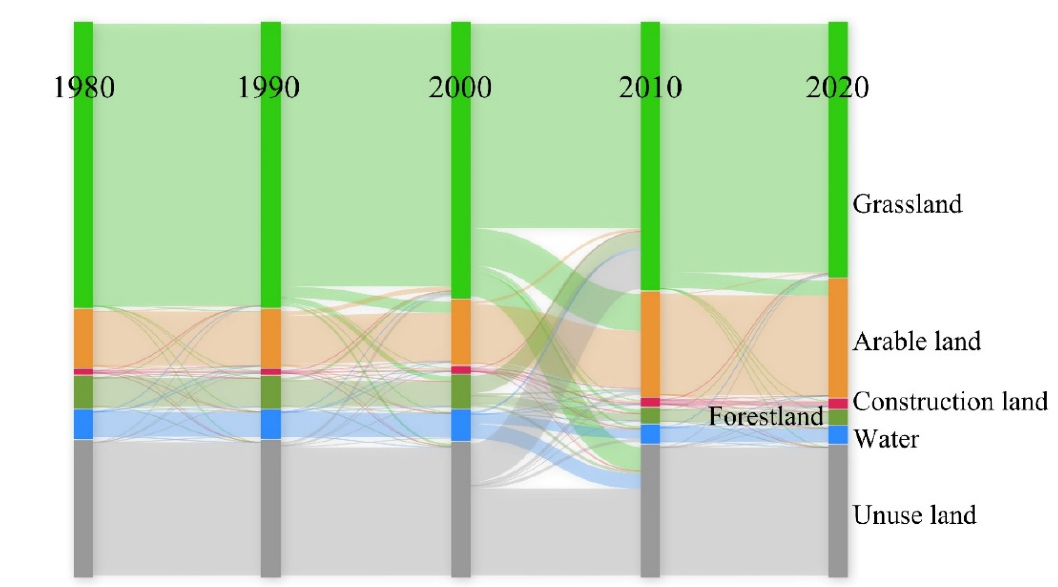
Figure 4. The transfer of land use types. Table 3. Land use transfer matrix (km 2 ).